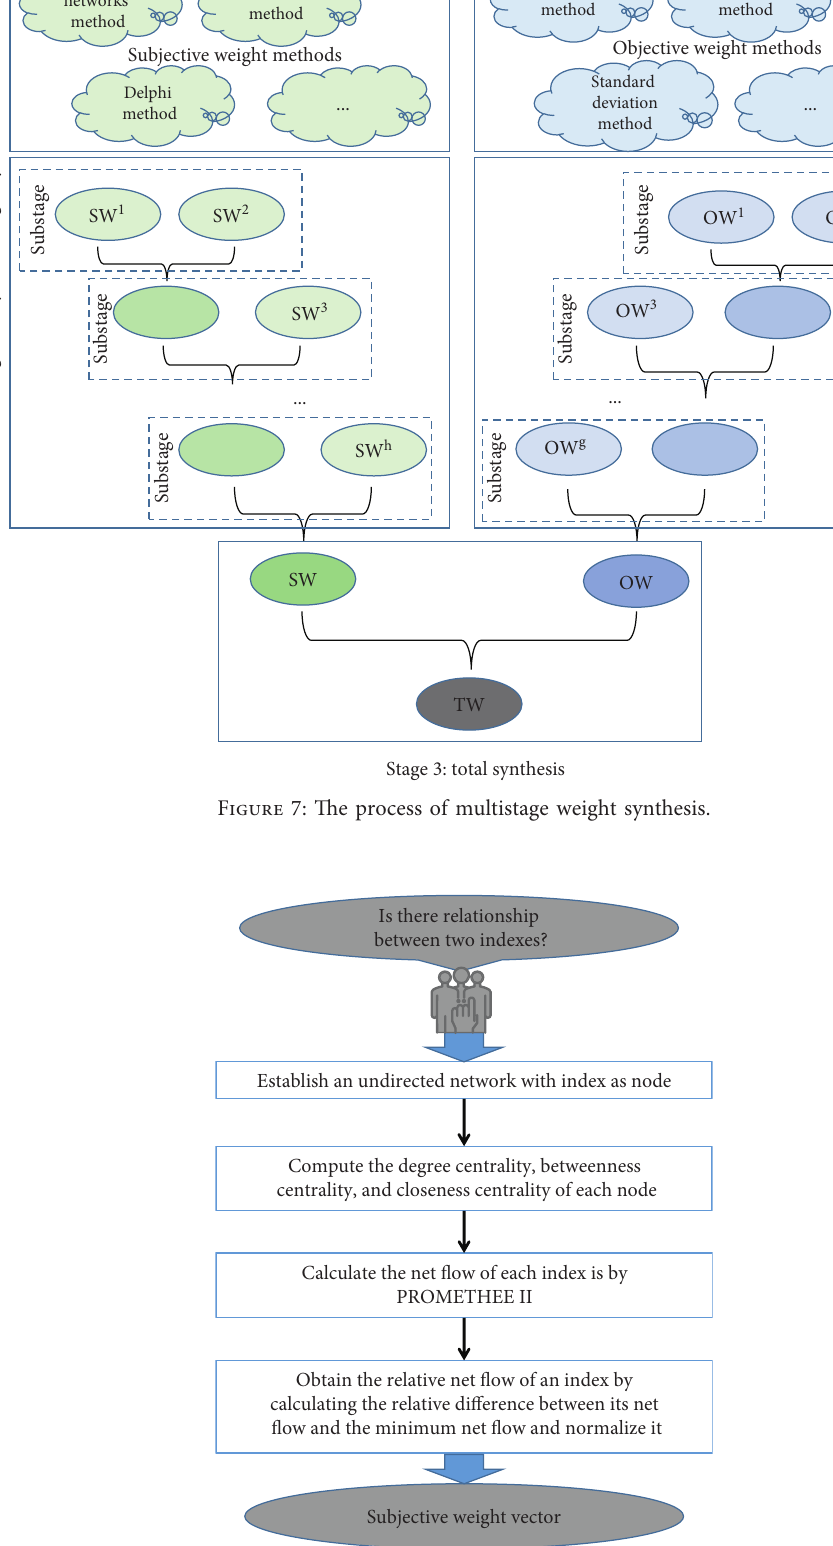
Figure 8: The process of obtaining subjective weight by complex networks